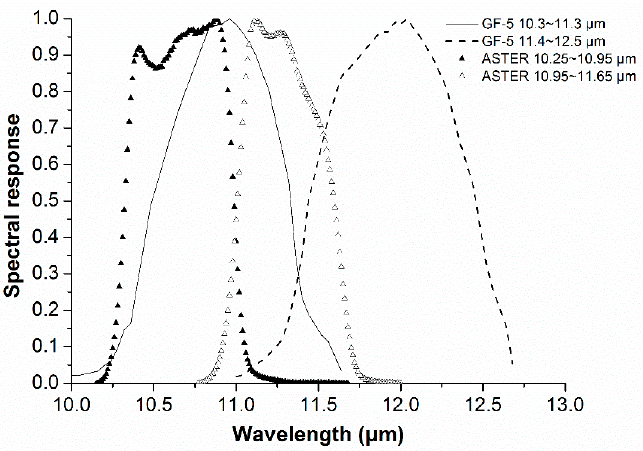
Figure 1. Spectral response functions of the GF-5 and ASTER split-window channels.